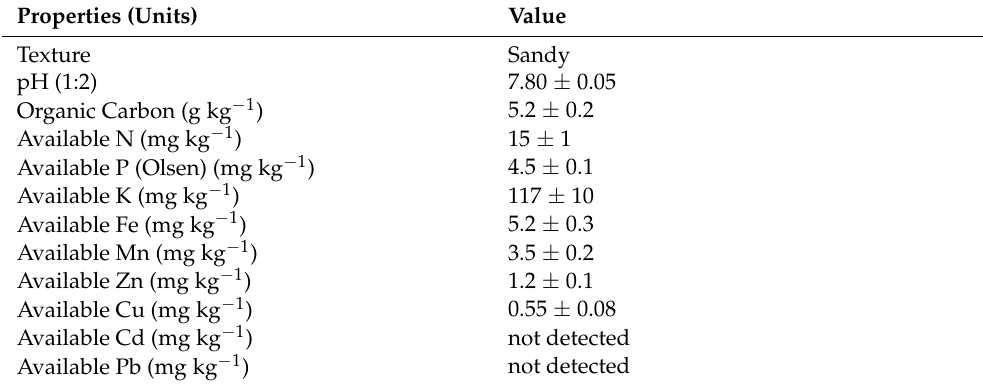
Table 2. Basic soil characteristics.